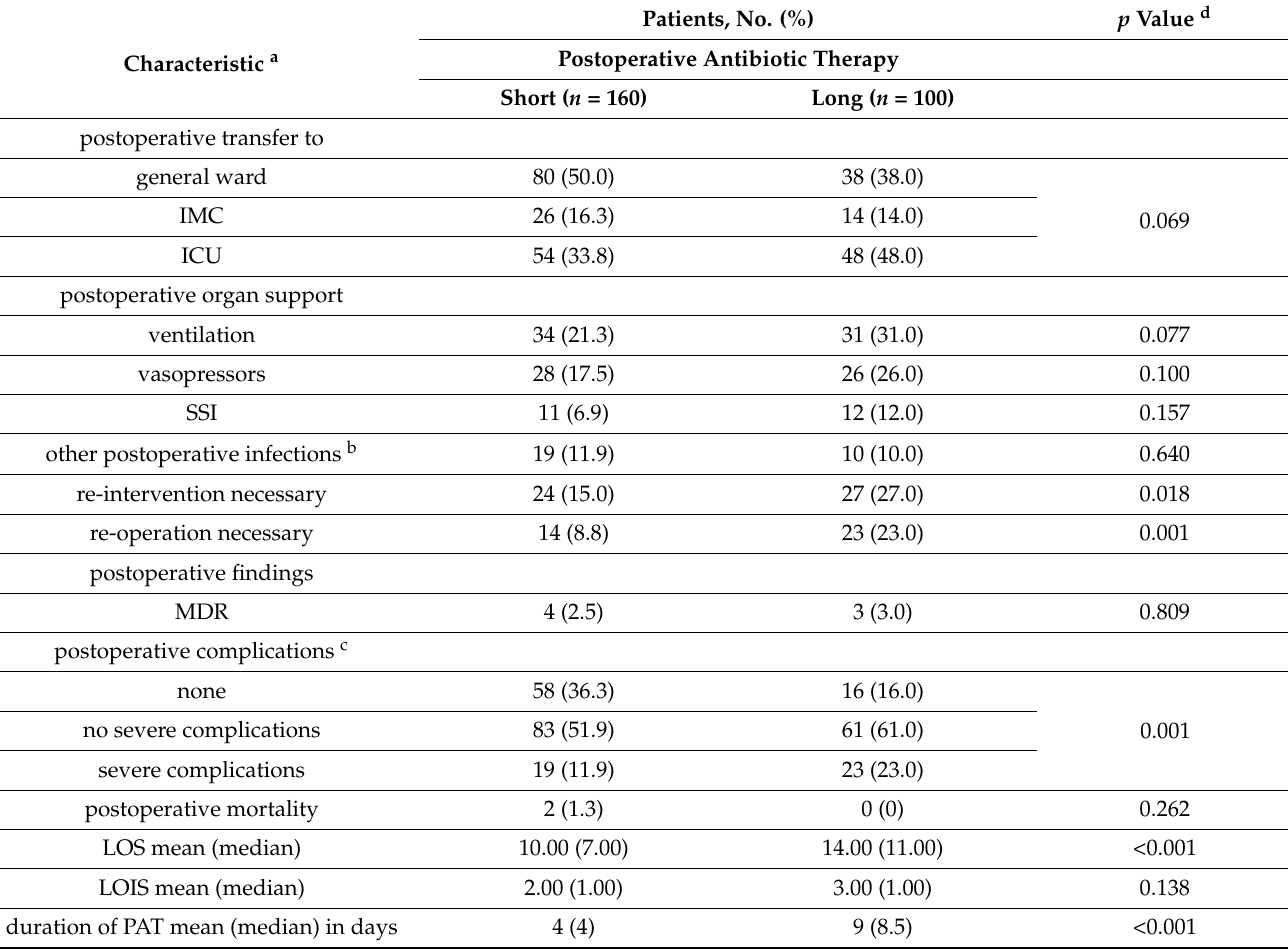
Table 2. Postoperative